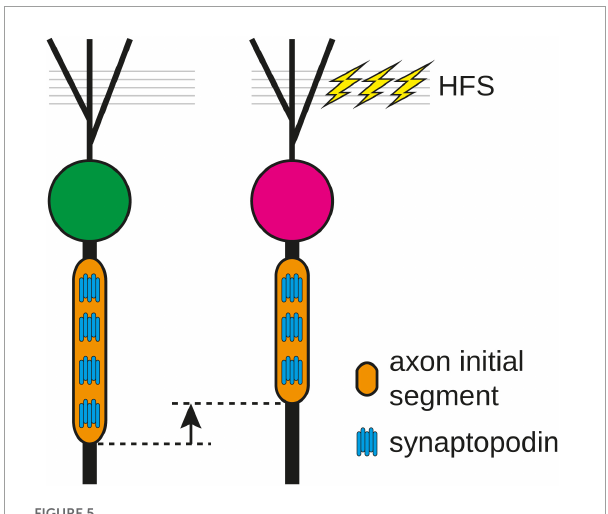
FIGURE5 Following 2 h high frequency stimulation (HFS) of the medial perforant path, the length of the axon initial segment (AIS) and the number of synaptopodin clusters were reduced, indicating that the number of cisternal organelles in the AIS is fine-tuned to its length and can be modified as a homeostatic response of the AIS to